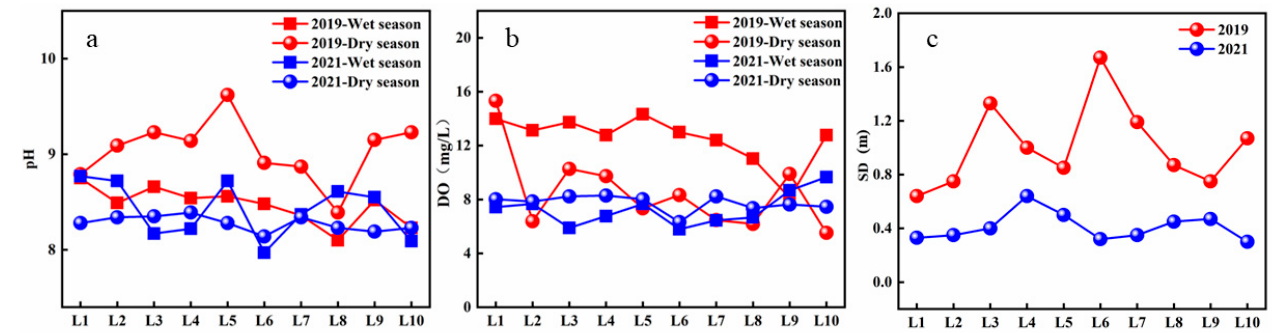
Figure 2. Distribution characteristics of environmental parameters: pH ( a ), DO ( b ), SD ( c ) in Caohai Lake (locations from L1 to L10).